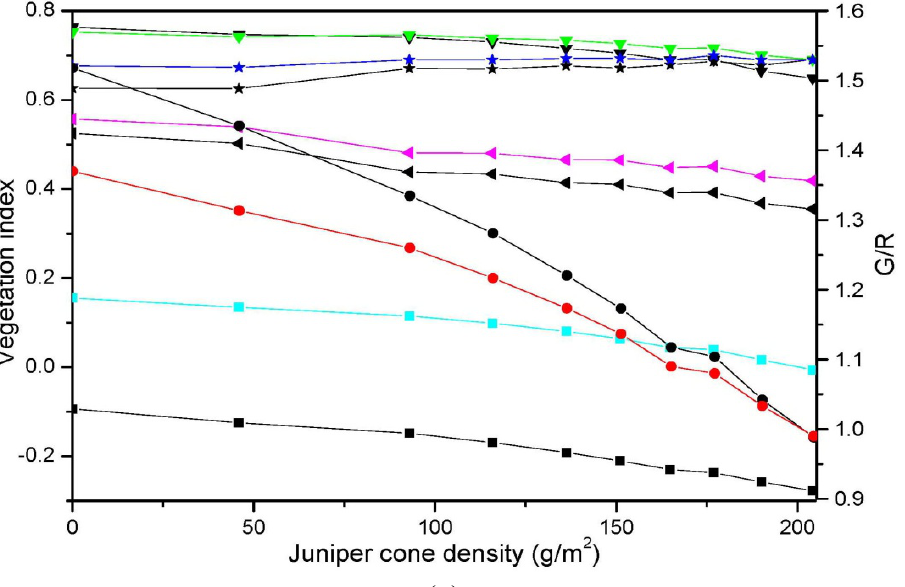
Figure 8. ( a ) Vegetation index and ( b ) Vegetation Index relative changeover different juniper cone densities, including MODIS broadband and narrow bands with the best-fit R 2 values in Table